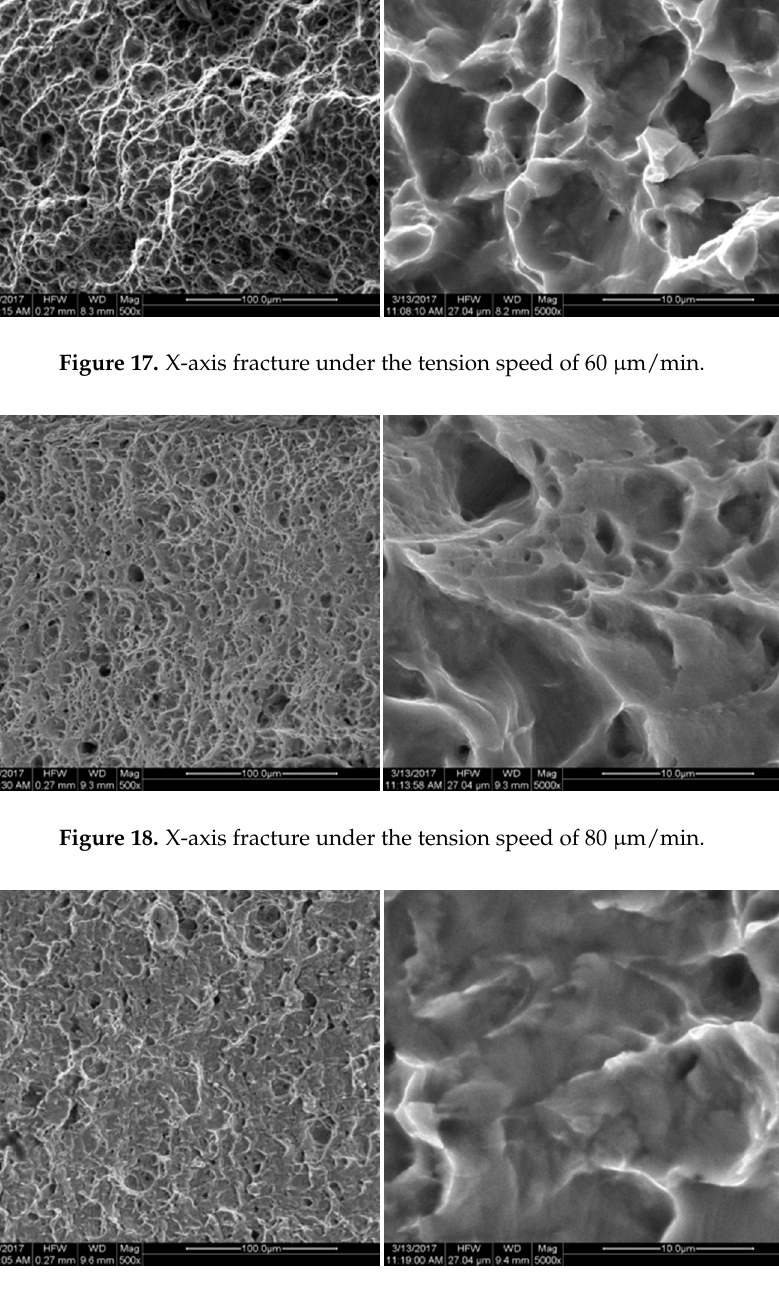
Figure 16. X-axis fracture under the tension speed of 40 μ m/min.